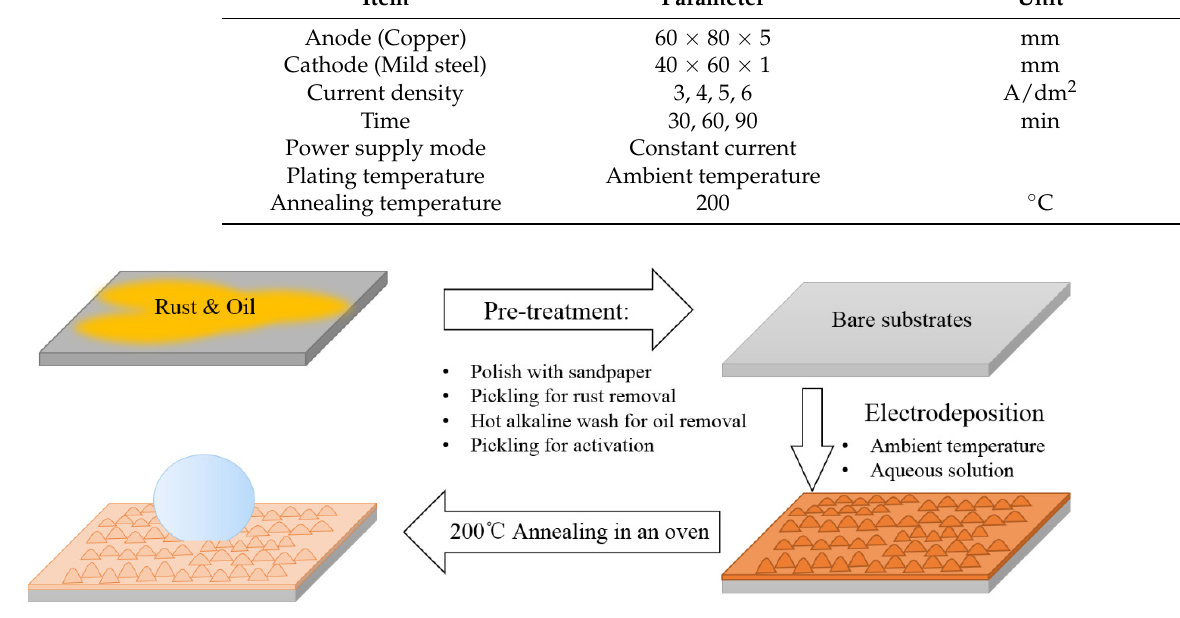
Figure 1. Mild steel-based superhydrophobic surface preparation process diagram.